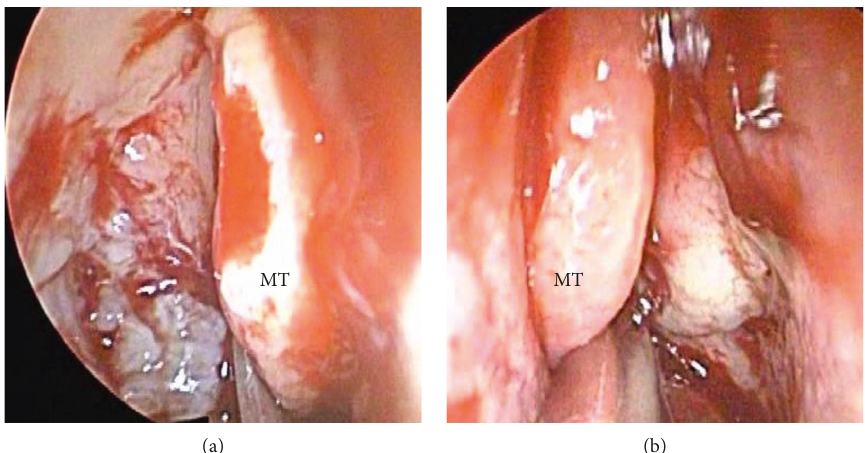
Figure 2: During endoscopic sinus surgery, granulomatous mucosa is apparent in the right (a) and left (b) ethmoid